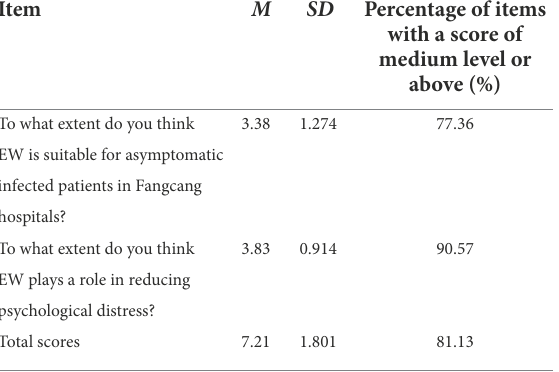
TABLE 6 Descriptive analysis of patients’ satisfaction with EW (score). Item M SD Percentage of items with a score